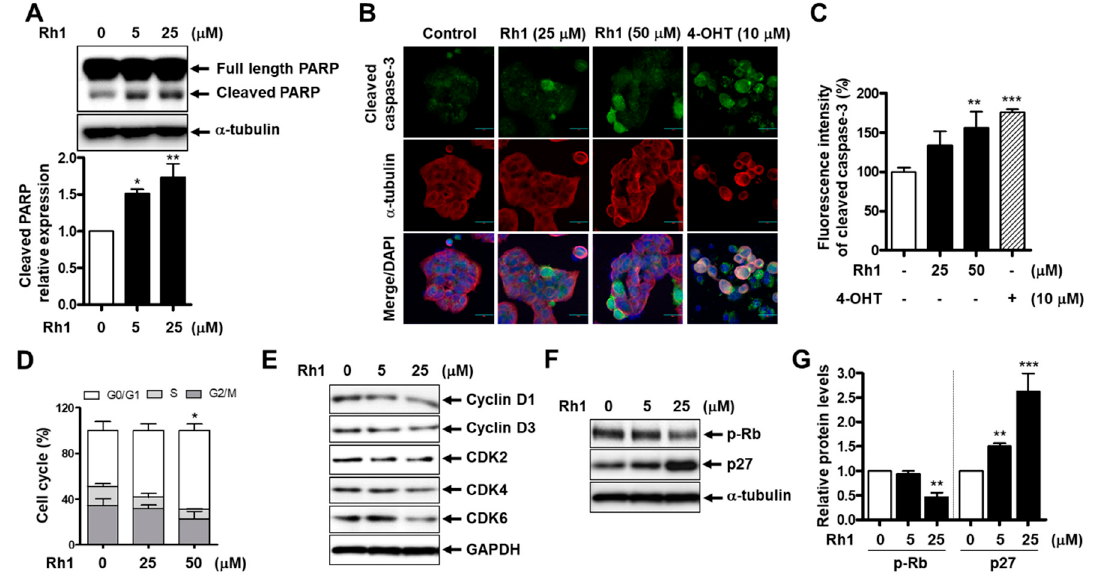
Figure 2. Rh1 induced cell apoptosis and cell cycle arrest in MCF-7 cells. ( A ) The cells were treated with Rh1 (0, 5, and 25 µ M) for 24 h. Whole-cell lysates were then used to analyze the protein expression as indicated. α -tubulin was used as a loading control. ( B , C ) The cells were treated with Rh1 (0, 25, and 50 µ M) or 4-OHT (10 µ M) for 24 h. An immunofluorescence analysis was performed after fixing and immunostaining. Images are shown at × 200 magnification ( B ). Scale bar indicates 30 µ m. Quantified graph showed the relative fluorescent intensity of cleaved caspase-3 using Image J software ( C ). ( D ) MCF-7 cells were treated with Rh1 at different concentrations for 24h. After the treatment, the cells were harvested for the cell cycle distribution analysis using flow cytometry. ( E ) The cells were treated with Rh1 (0, 5, and 25 µ M) for 24 h. Total cell lysates were analyzed by Western blotting using the indicated antibodies. ( F , G ) The cells were treated with Rh1 (0, 5, and 25 µ M) for 24 h. Total cell lysates were analyzed by Western blotting using the indicated antibodies ( F ). The relative quantification of the protein levels was analyzed by Image J software ( G ). ( A , C , D , G ) Data are expressed as the mean ± SD ( n = 5 ), * p < 0.05, * * p < 0.01, and ** * p < 0.001 as compared with the control. 4-OHT: 4-hydroxytamoxifen, CDK: cyclin-dependent kinase, and GAPDH: glyceraldehyde 3-phosphate